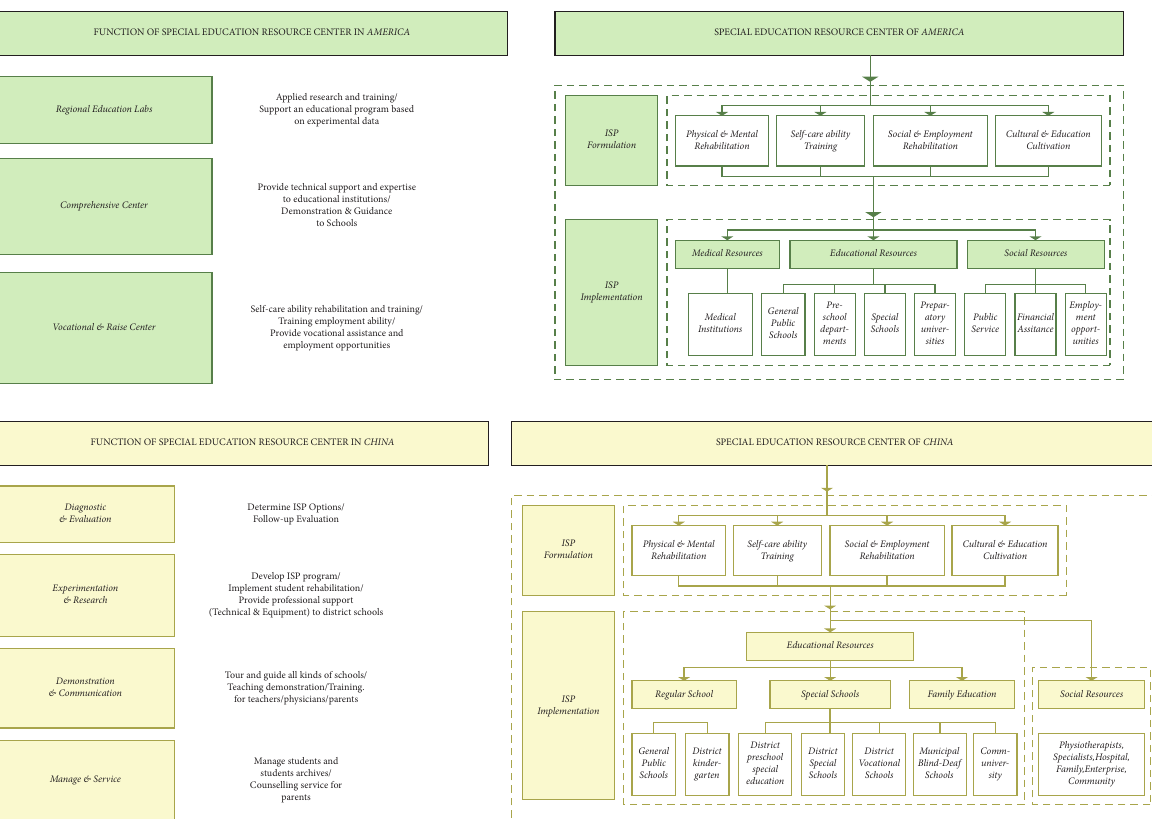
Figure 2: Resource center function and ISP program support